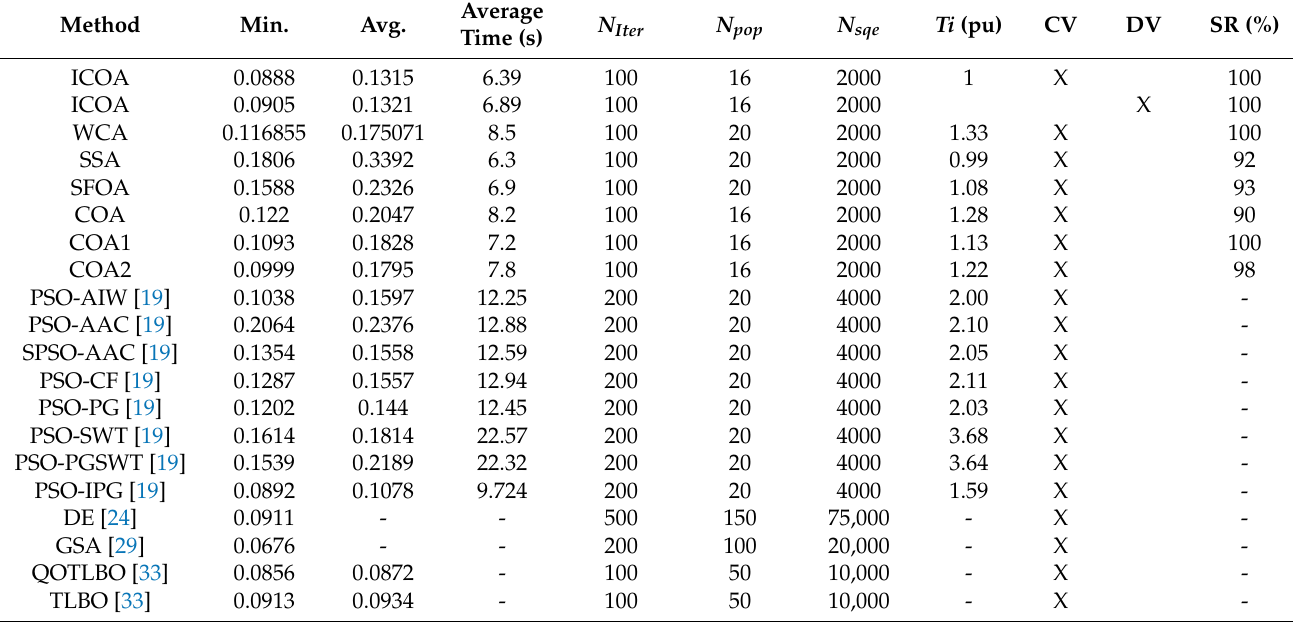
Table 6. Result comparison of TVD objective for the IEEE 30-bus